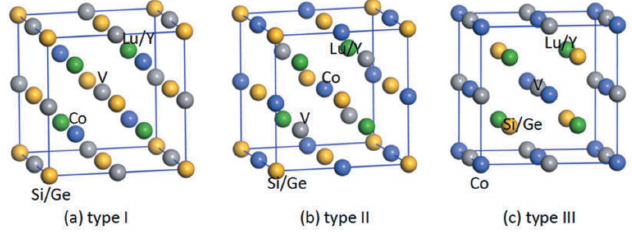
Figure 2 Crystal structures in conventional unit cells for three different types of Wyckoff coordinate for atoms in rare earth-containing EQH compounds with the formula M CoV Z ( M = Lu, Y; Z = Si, Ge).